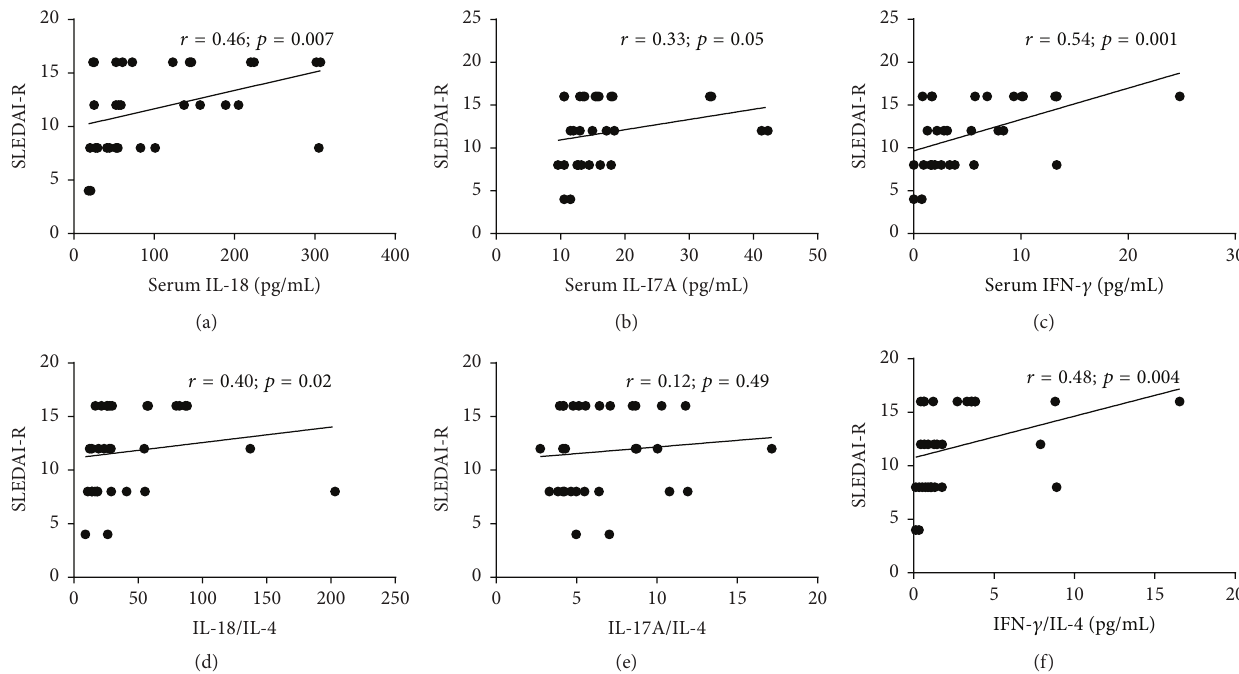
Figure 5: Correlation of serum levels cytokines Th1 (IL-18 and IFN- 𝛾 ), Th17 (IL-17A), ratio of Th1/Th2 (IL-18/IL-4 and IFN- 𝛾 /IL-4), and Th17 (IL-17/IL-4) with renal SLEDAI. Spearman correlation test was used to analyze the correlationship between two parameters. 𝑝 value < 0.05 was considered statistically